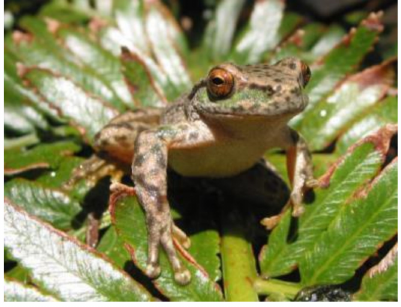
Figure A2. Spotted tree frog (Glen Johnson).